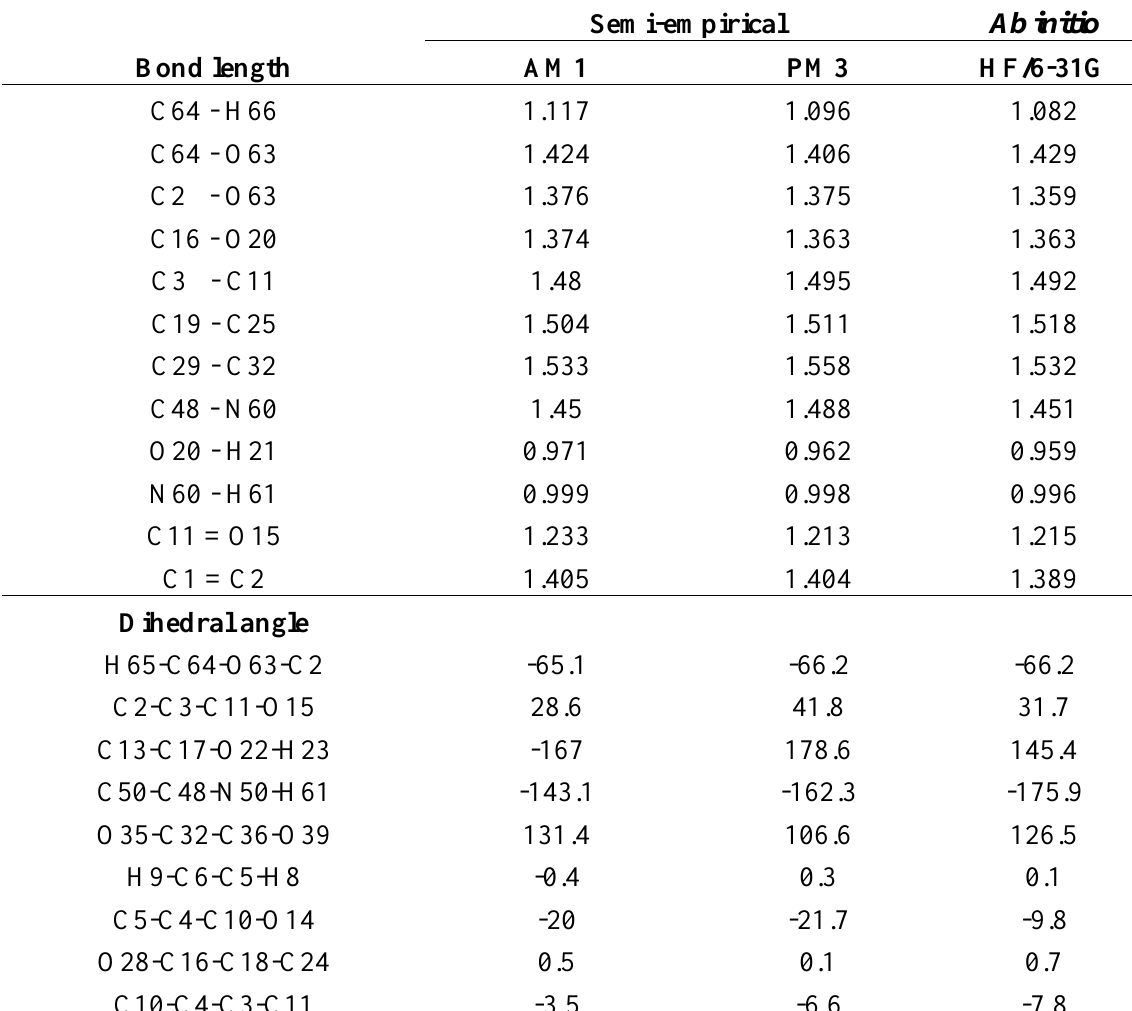
Table 1. Geometric parameters of optimized doxorubicin structure.